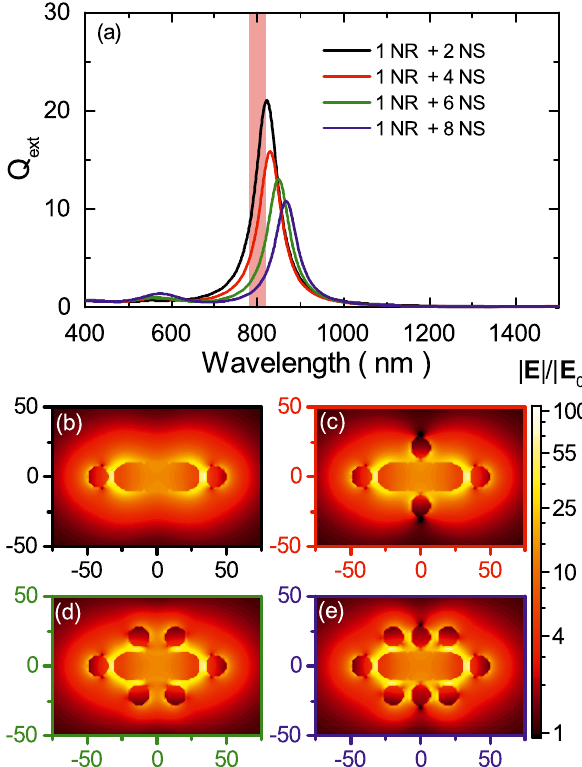
Figure 4: (a) Simulated extinction efficiency ( Q ext ) calculated for different structures, composed of a nanorod surrounded by a varying number of satellite spheres, as indicated in the